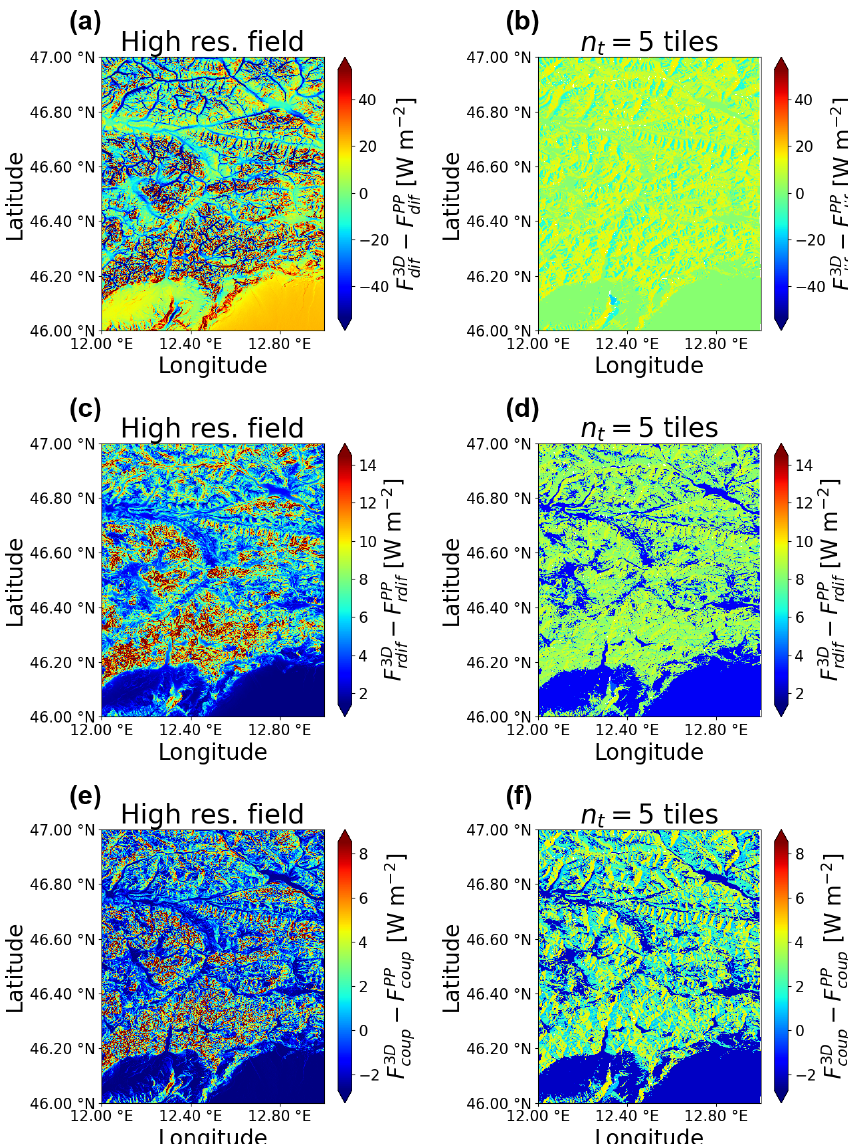
Figure 15. The same as Fig. 14 for diffuse, reflected diffuse, and coupled flux